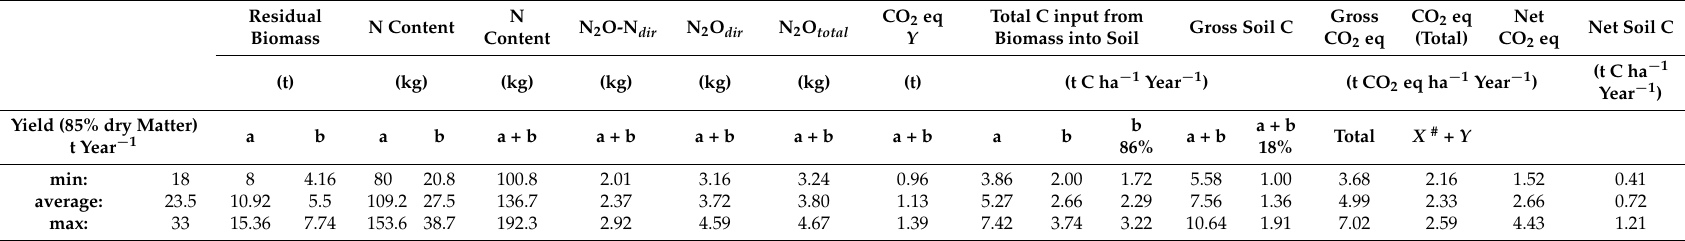
Table 3. Direct and indirect N 2 O emissions and carbon sequestration potential from Miscanthus cultivation calculated for minimal, average and maximal Miscanthus yield (detailed calculation is given in Section 2 of Supplementary